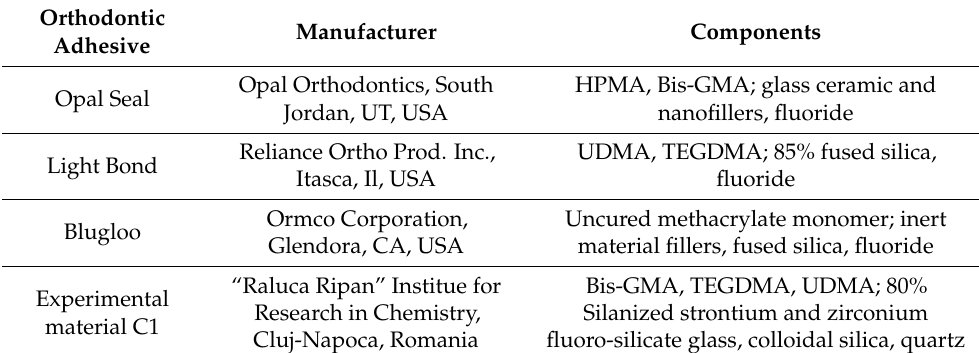
Table 1. Orthodontic adhesives included in the study.